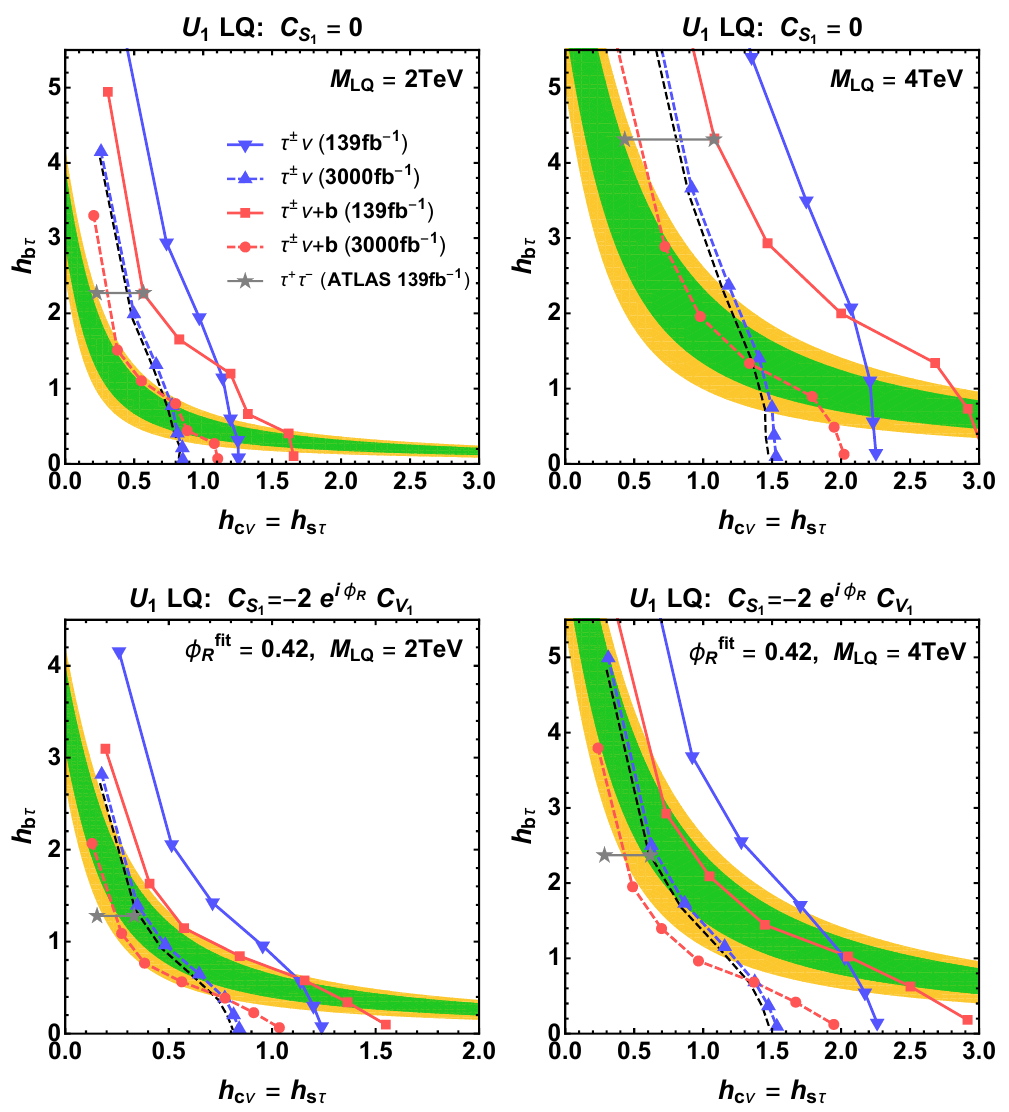
Figure 5 . Expected sensitivities to the U 1 LQ scenario as functions of the LQ couplings with the LQ mass of 2 TeV (left) and 4 TeV (right). The black dashed lines show the results with selecting τ − ν . The gray horizontal lines correspond to the current LHC bound recast from the ATLAS pp → τ + τ − search. See figure 4 for other color